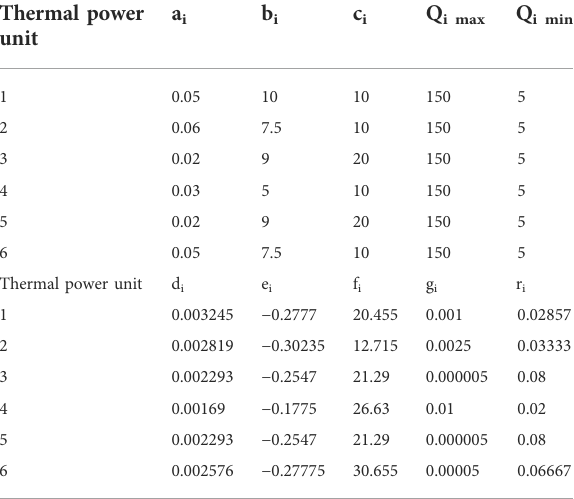
TABLE 1 Data of the six